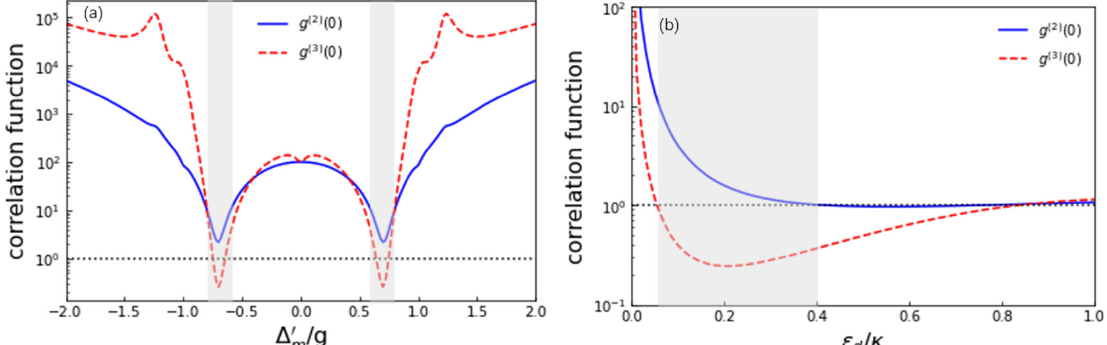
Figure 5. Steady-state equal-time second-order correlation function g ( 2 ) ( 0 ) and third-order correla- tion function g ( 3 ) ( 0 ) versus ( a ) the detuning ∆ (cid:48) m / g and ( b ) the driving strength ε d / κ when the optical cavity is weakly driven. The system parameters are γ = 0.01 κ , n th = 0, g = 3 κ , ( a ) ε d = 0.15 κ and ( b ) ∆ (cid:48) m = ± √ 2 𝑔 .